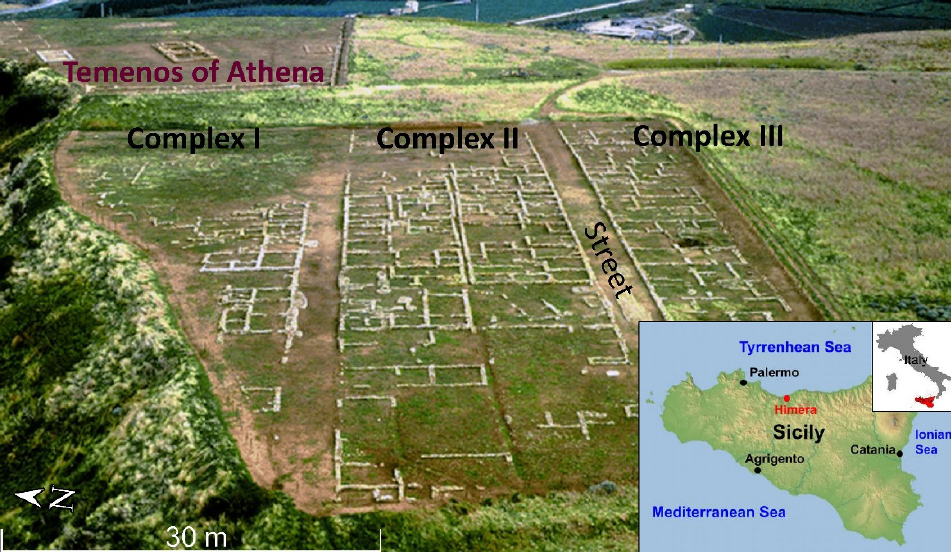
Figure 2. Aerial view (from west) of the test site of Himera and its geographical location.